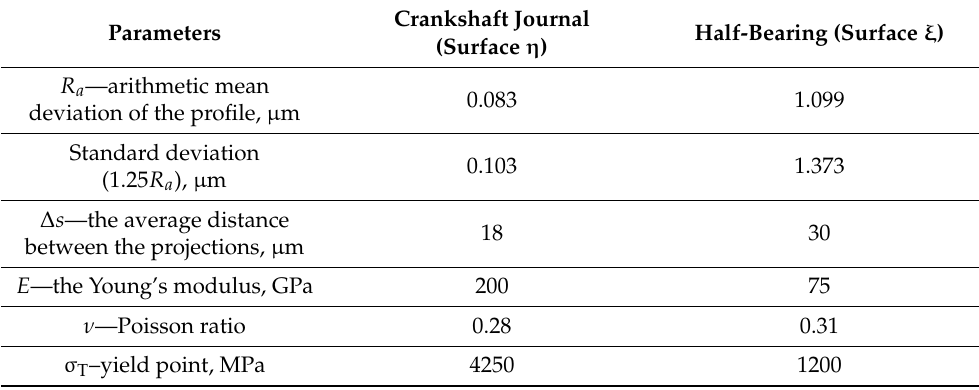
Table 1. Initial parameters of mating